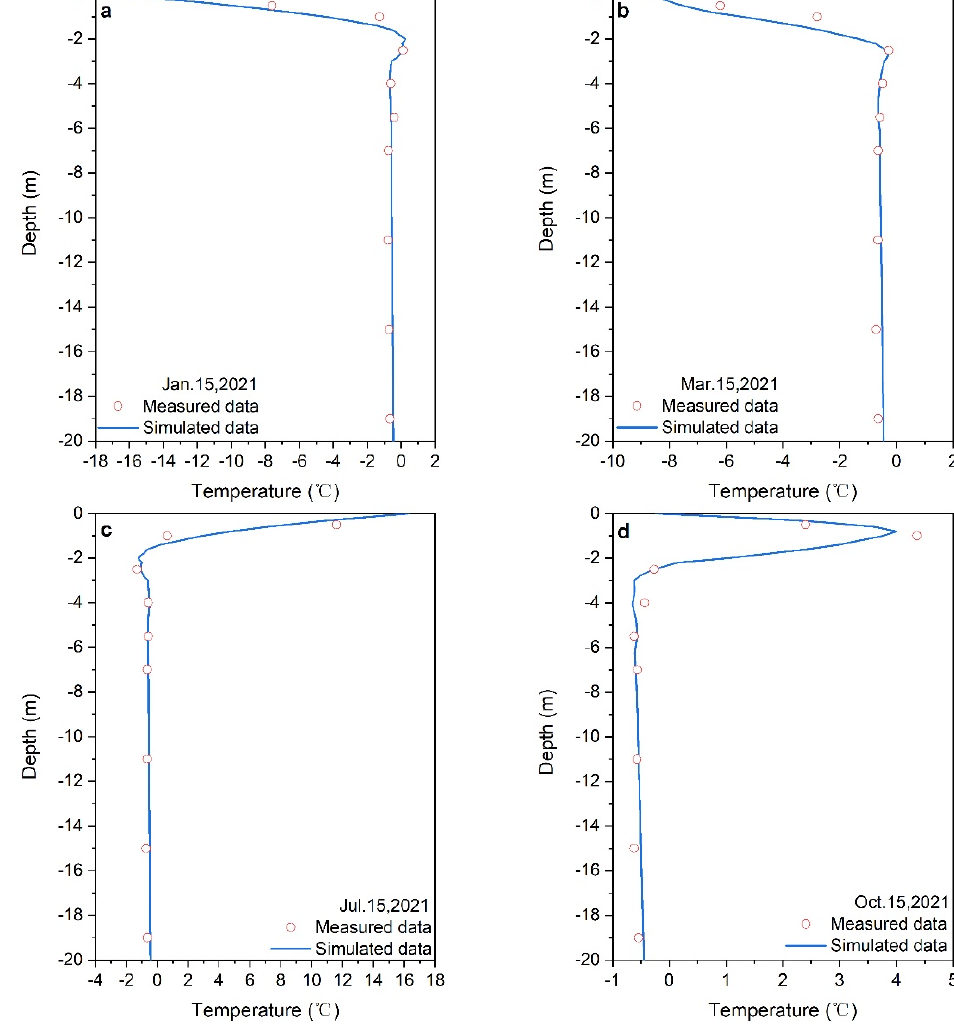
Figure 3. Comparison of the measured and simulated ground temperatures of the borehole at the foot of the slope from 15 January 2021, to 15 October 2021.